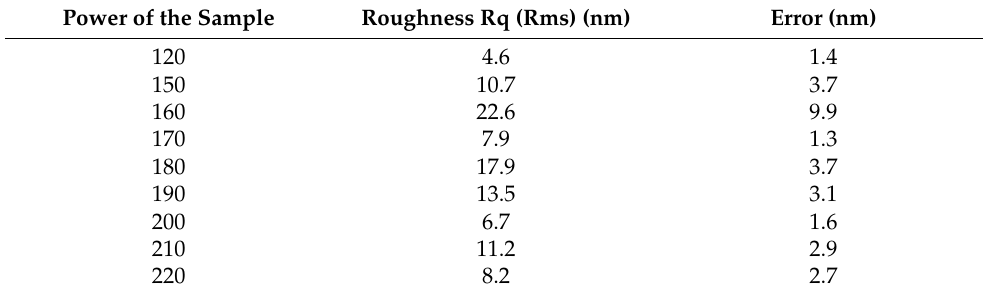
Table 2. Rq Roughness (Rms) of TaN films synthesized using the magnetron sputtering technique. Power of the Sample